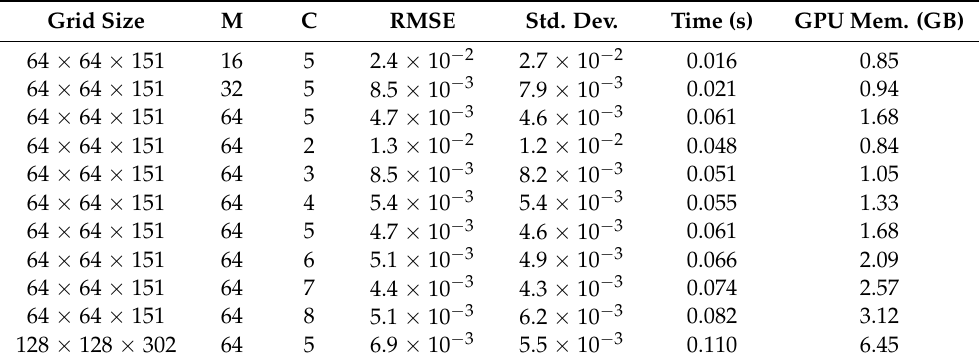
Table 1. Comparison of FNO network hyperparameters.